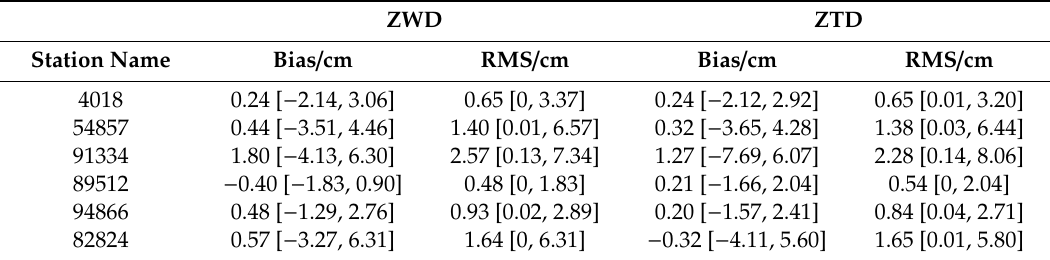
Figure 11. ZTD bias time series of stations ( a ) 04018, ( b ) 54857, ( c ) 91334, ( d ) 89512, ( e ) 94866 and ( f ) 82824 derived from the MERRA-2 data from 2015 (the content in parentheses indicates the latitude, longitude and altitude of the radiosonde station).